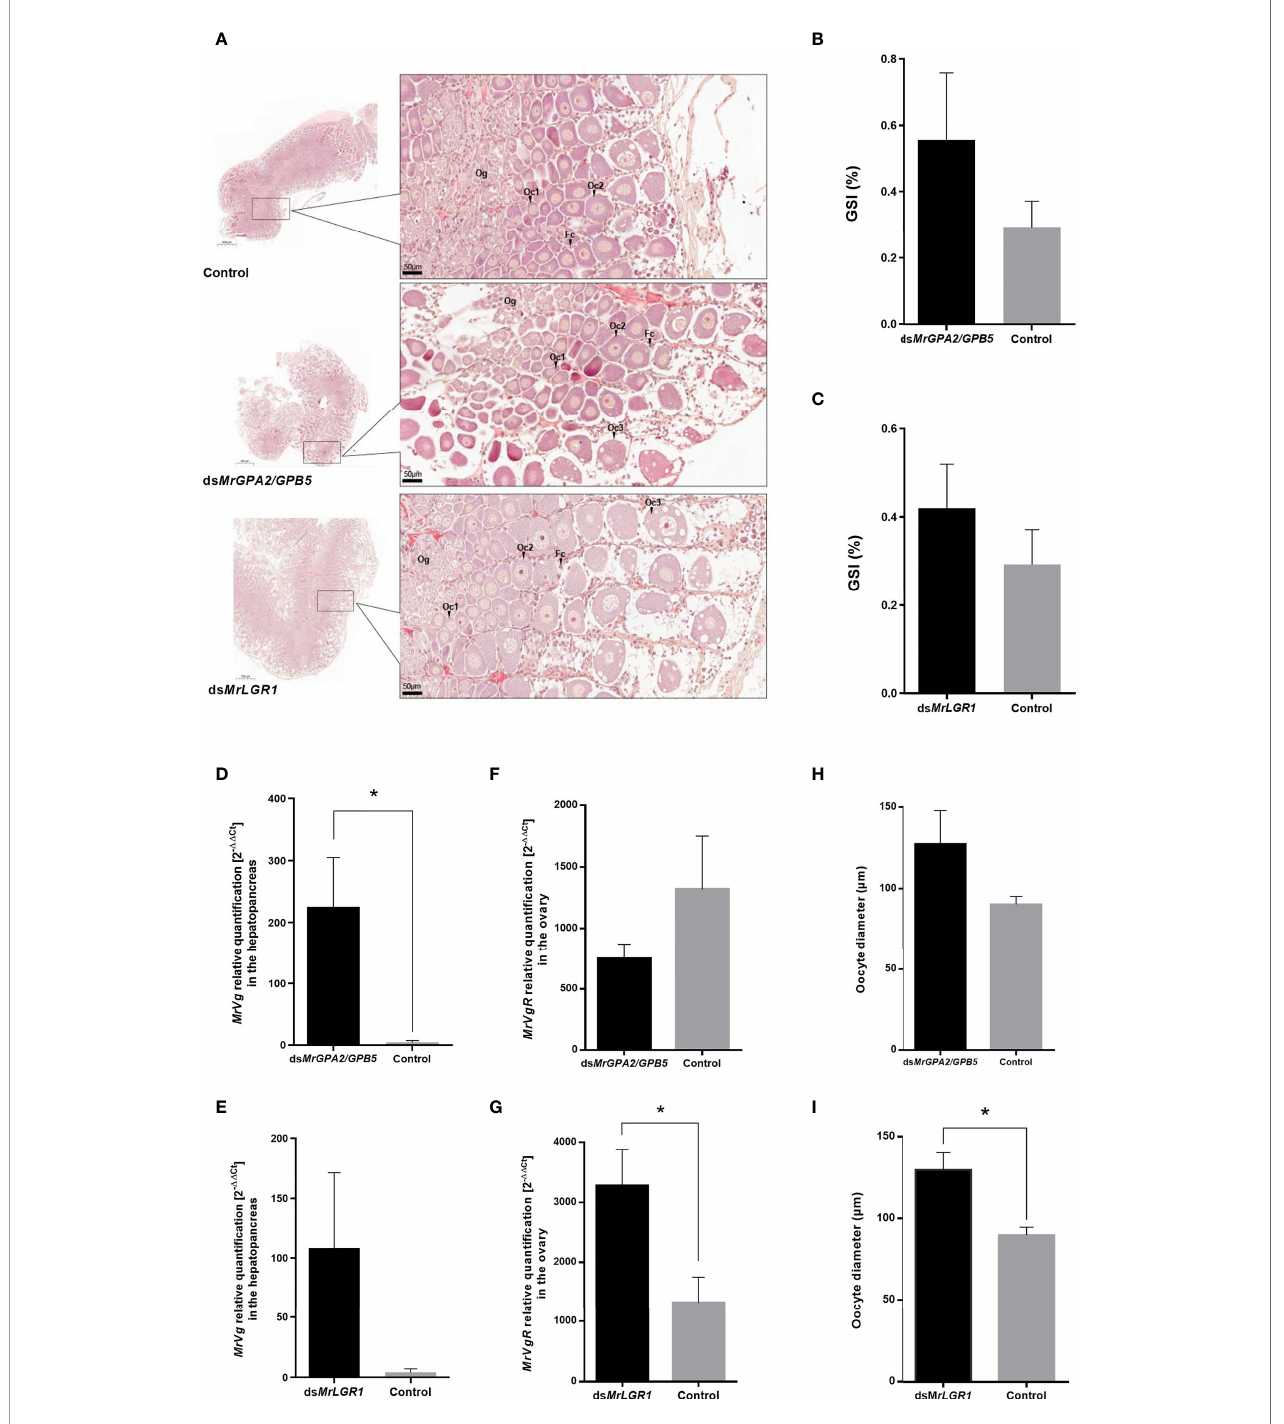
FIGURE 8 | Reproductive effects following long-term MrGPA2/GPB5 and MrLGR1 loss of function experiments. (A) Representative histological sections of ovaries of control (dsGFP injected; top), ds MrGPA2/GPB5 -injected and ds MrLGR1- injected (bottom) females. MrGPA2/GPB5 (top panels) and MrLGR1 (bottom panels) knockdown effects on (B, C) M. rosenbergii gonado-somatic index (GSI), (D, E) vitellogenin ( MrVg ) relative transcript levels in the hepatopancreas, (F, G) vitellogenin receptor ( MrVgR ) relative transcript levels in the ovary and (H, I) oocyte diameter. Error bars represent standard error of the means. *Statistically signi fi cant difference ( P < 0.05, t